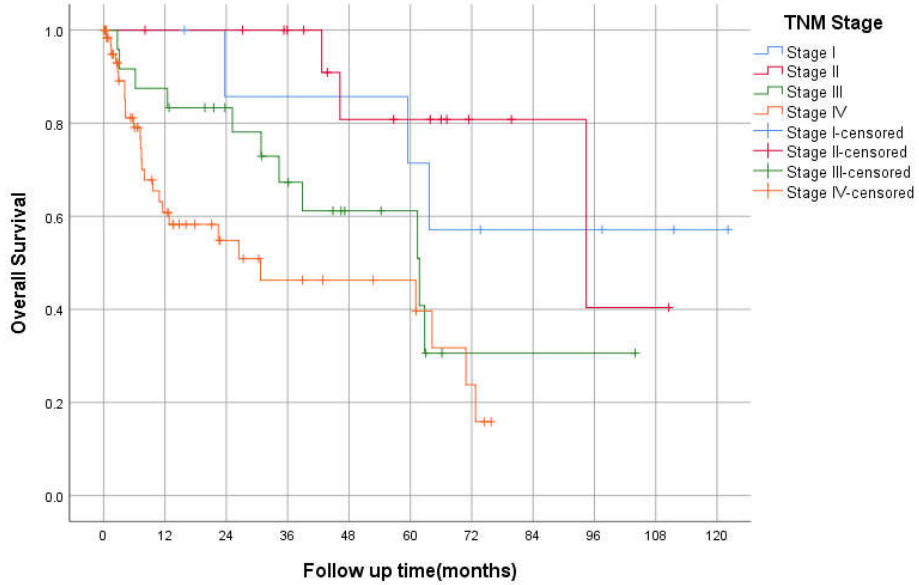
Figure 2. Kaplan–Meier curve of Overall Survival based on TNM Staging.